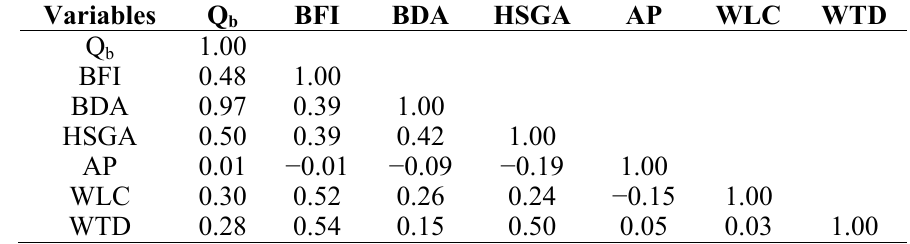
Table 4 . Correlation analysis of variables as used for the development of regression